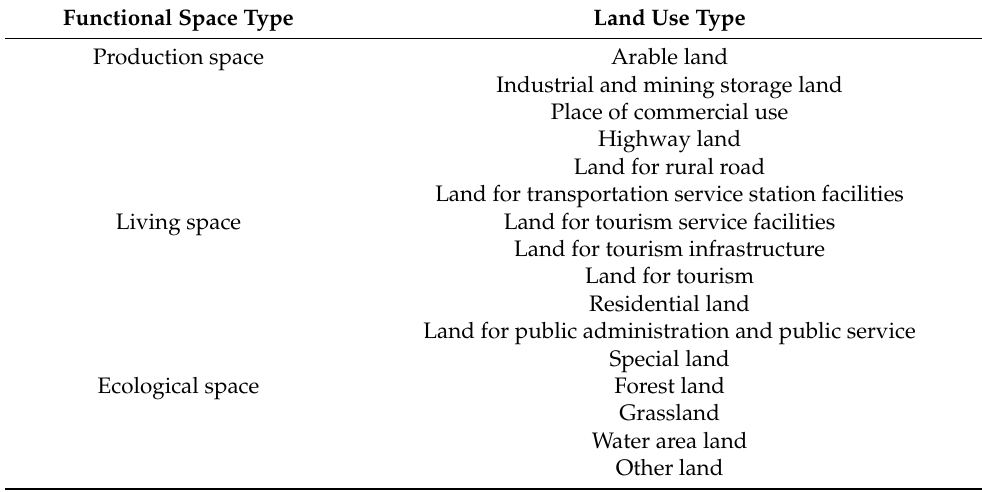
Table 1. Classification system of rural functional